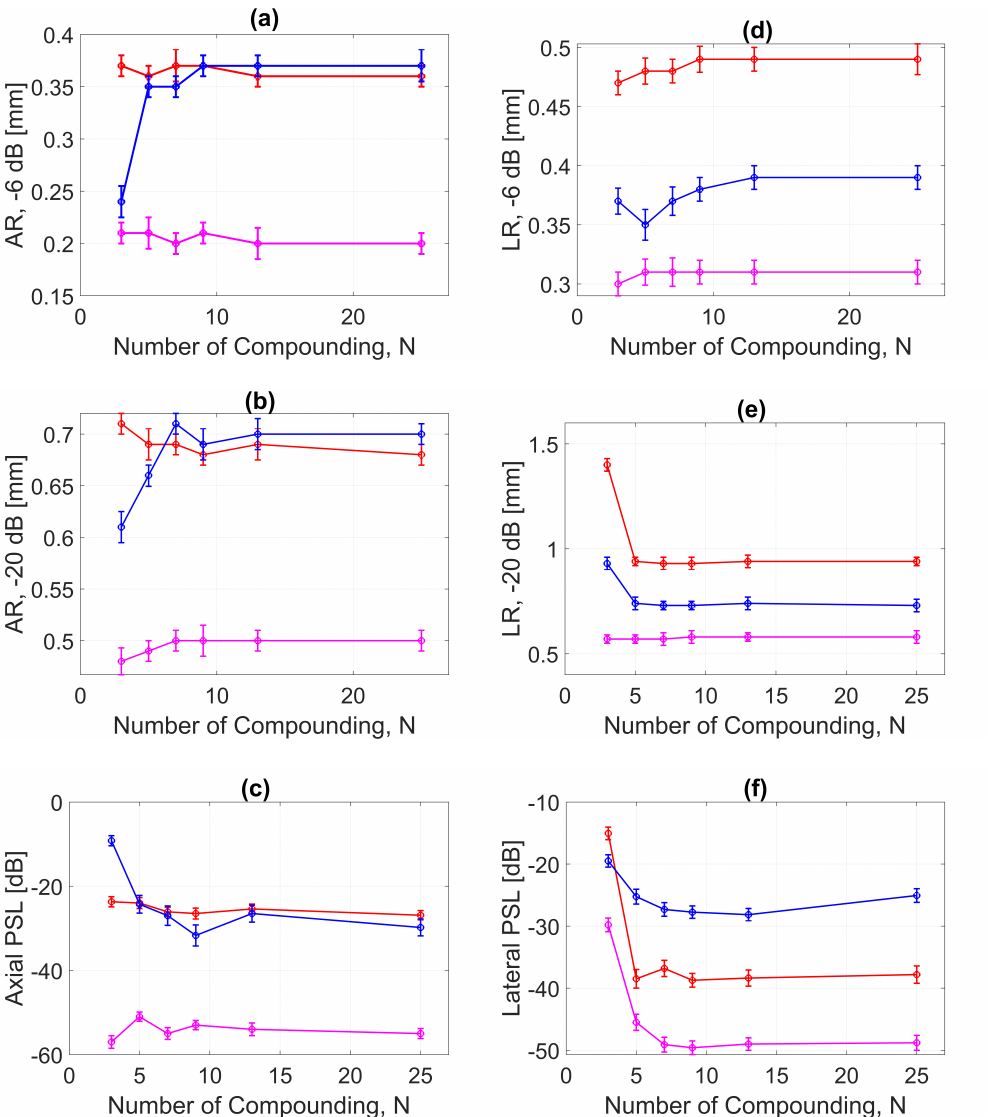
Figure 13. ARs for DAS, FDMAS and DAS-FMAS at the ( a ) − 6 dB and ( b ) − 20 dB levels were measured at a depth of 30 mm on the wire target. The PSL along the axial direction is presented in ( c ). The LR for DAS, FDMAS and DAS-FMAS at ( d ) − 6 dB and ( e ) − 20 dB measured at a 30 mm depth. The PSL along the lateral direction is presented in ( f ). Red, blue, and magenta color lines represent DAS, FDMAS, and DAS-FMAS,